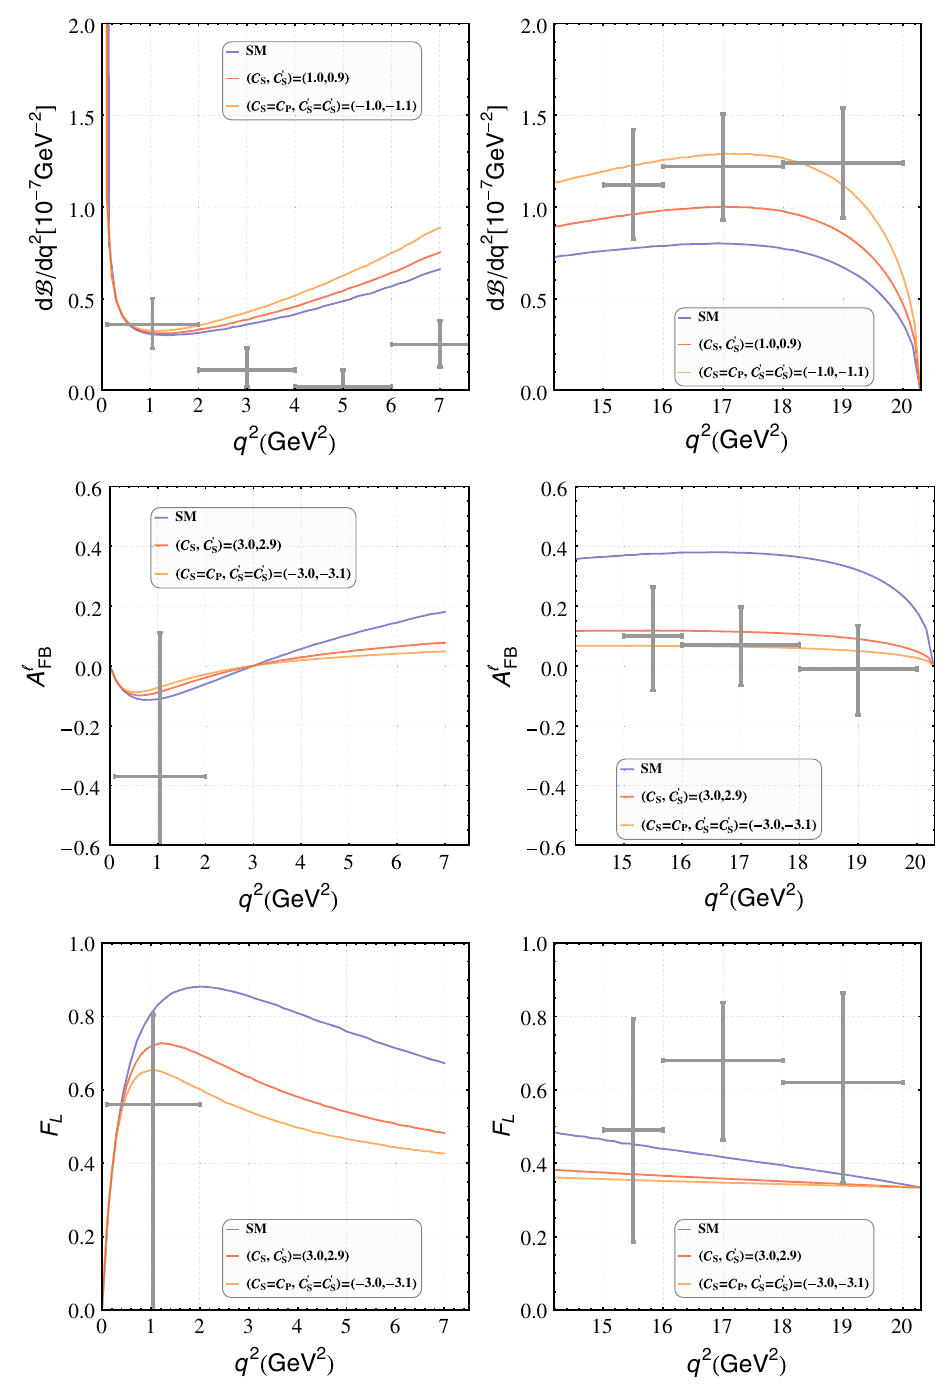
Fig. 3 The (cid:2) b → (cid:2)μ + μ − observables in the SM (blue) and for some new SP couplings (shades of red). The points shown by cross marks indicate LHCb data [22]